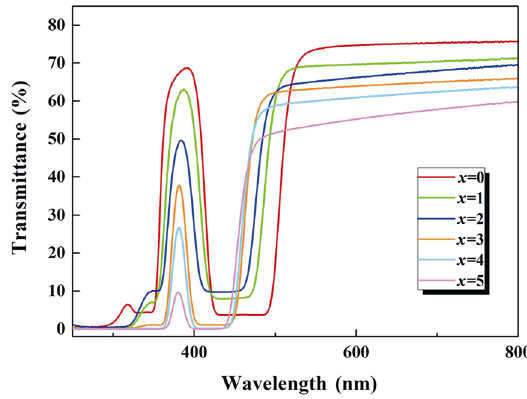
Fig. 6 Transmission spectra of Y 3 Al 5– x Ga x O 12 :Ce ( x = 0–5) ceramics.